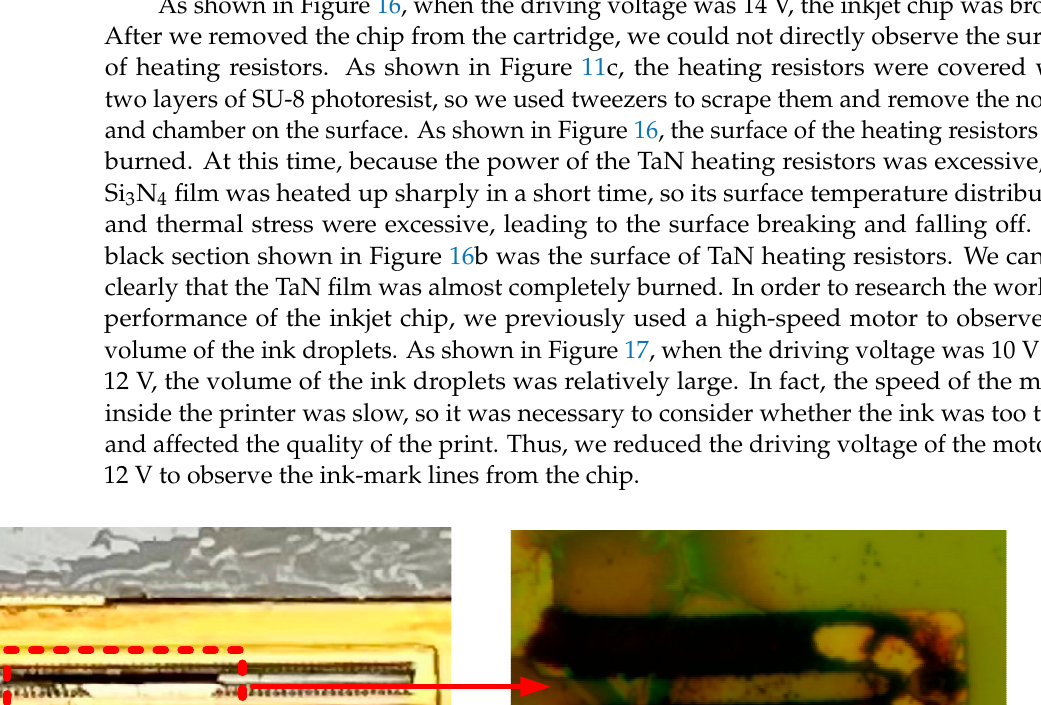
Figure 16. When the driving voltage was 14 V, the inkjet chip is burned. ( a ) Under the microscope, we used tweezers to scrape the SU-8 photoresist off the surface of the chip, and the nozzle and chamber were removed to facilitate the observation of heating resistors. ( b ) The heating resistors were burnt out due to the excessive voltage.